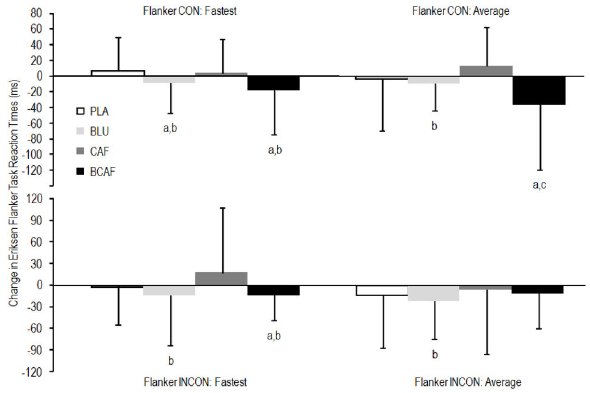
Figure 6. Change in Karolinska sleepiness scale ratings over time. a: small difference from PLA, b: small difference from BLU, c: small difference from BCAF, d: moderate difference from BCAF. PLA: white light/placebo; CAF: white light/240 mg caffeine; BLU: blue light/placebo; BCAF: blue light/240 mg caffeine, AU: Arbitrary units. doi: Figure 6. No relationships were observed between the post- treatment KSS or the change in KSS scores and any measures of cognitive function or psychomotor ability.